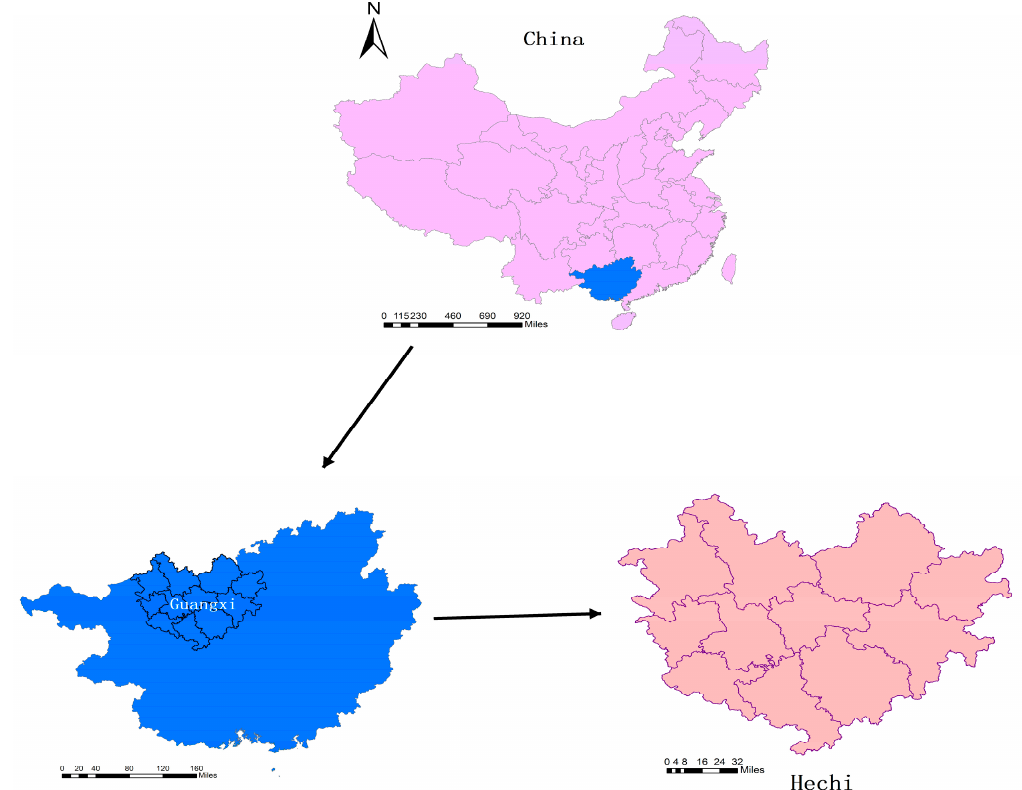
Figure 1. Location of the study area, Hechi city in China.